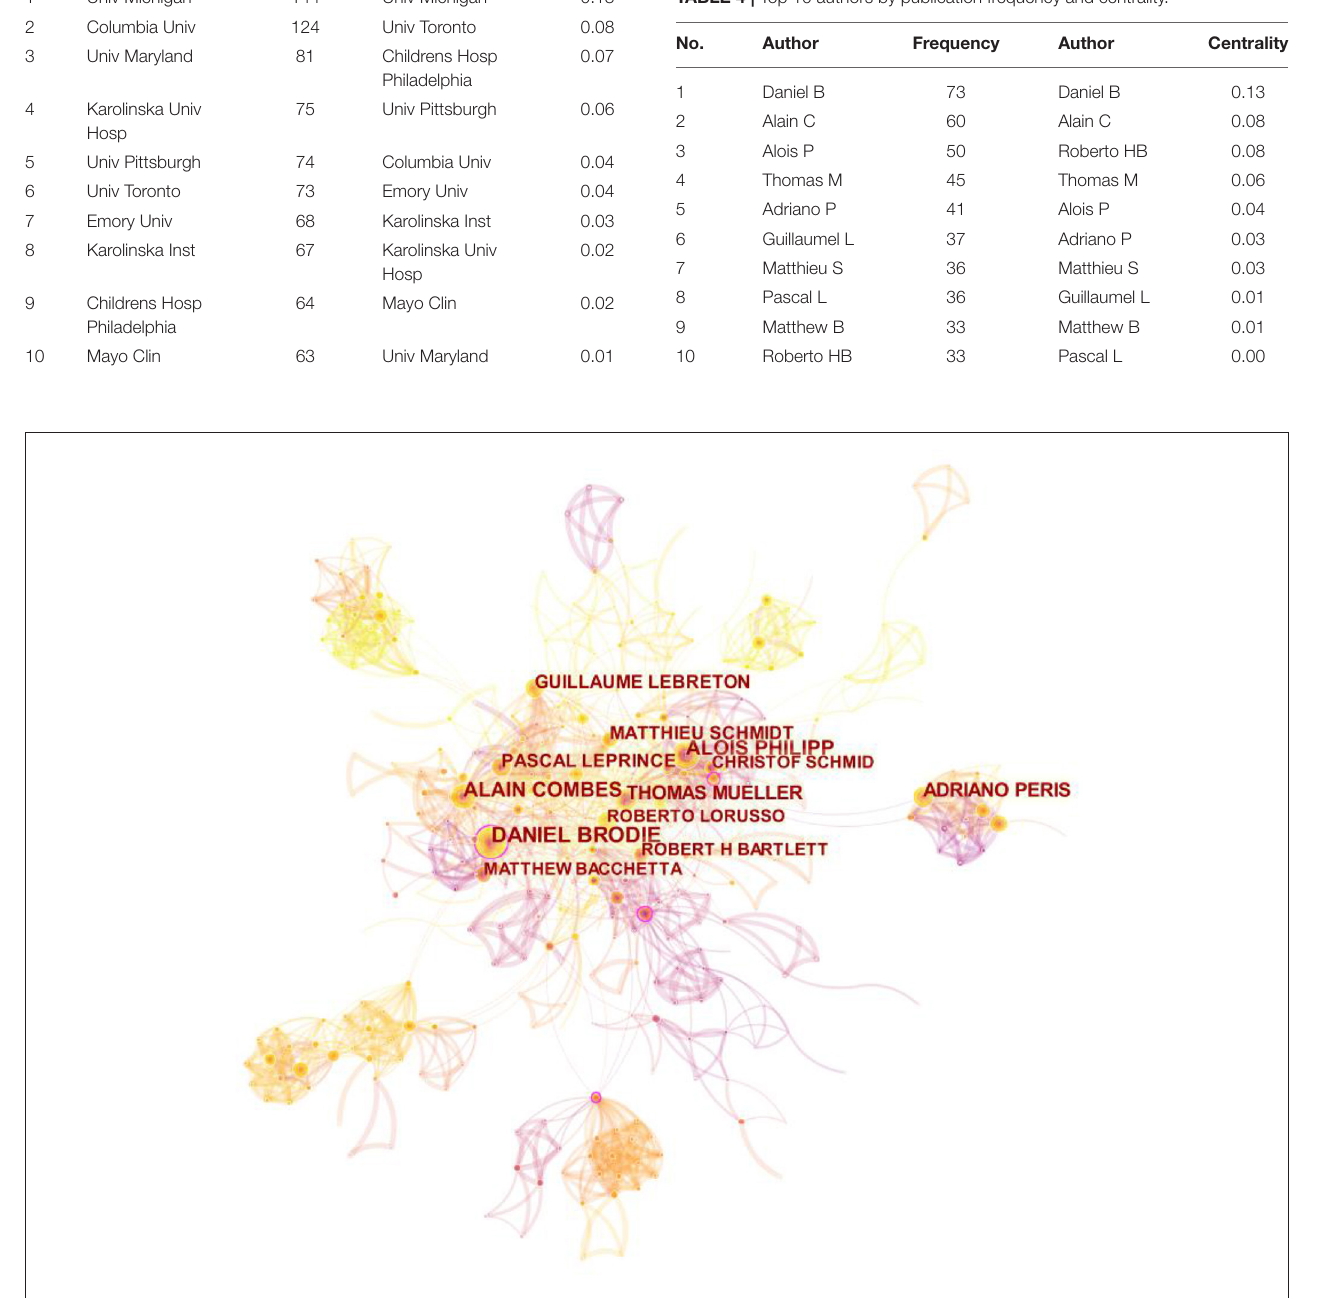
Frontiers in Medicine |